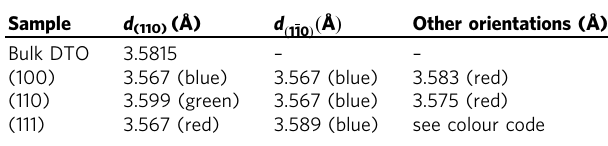
Table 2 DTO||YTO( hkl ) structural distortion with ( hkl ), the out-of-plane growth